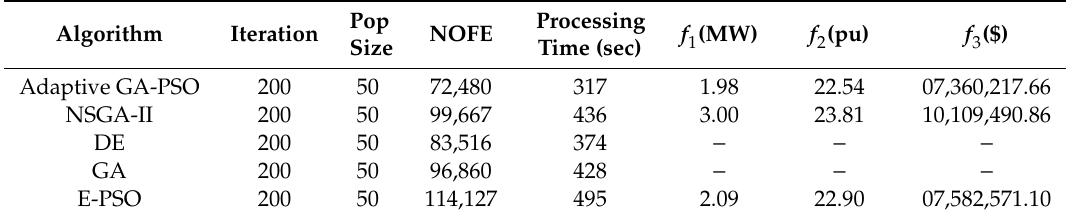
algorithm with literature (scenario